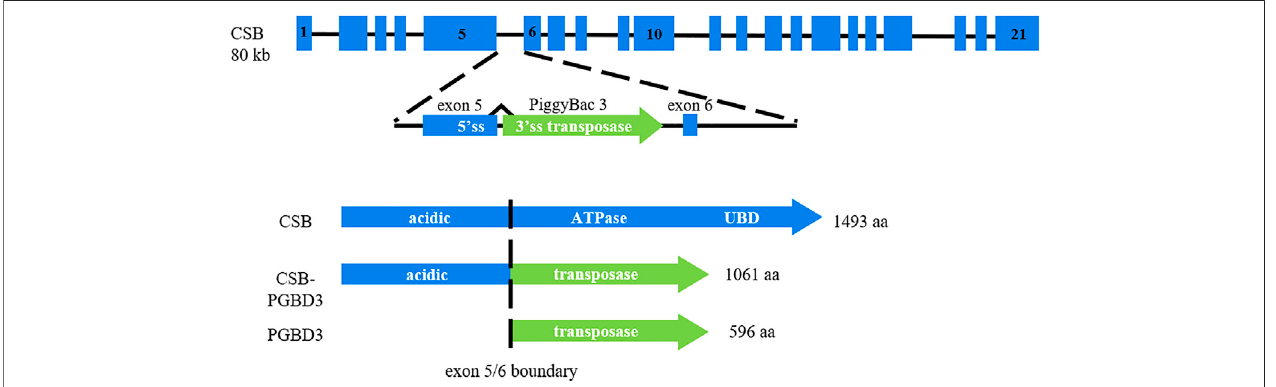
FIGURE 1 | PGBD3 transposon into intron 5 of the CSB/ERCC6 gene. Alternative splicing of CSB exons 1-5 to the PGBD3 transposase splice acceptor site enables the CSB-PGBD3 fusion protein expression. The primate CSB locus generates two other proteins: full length CSB and solitary PGBD3 transposase. Figure inspired from Gray et al.